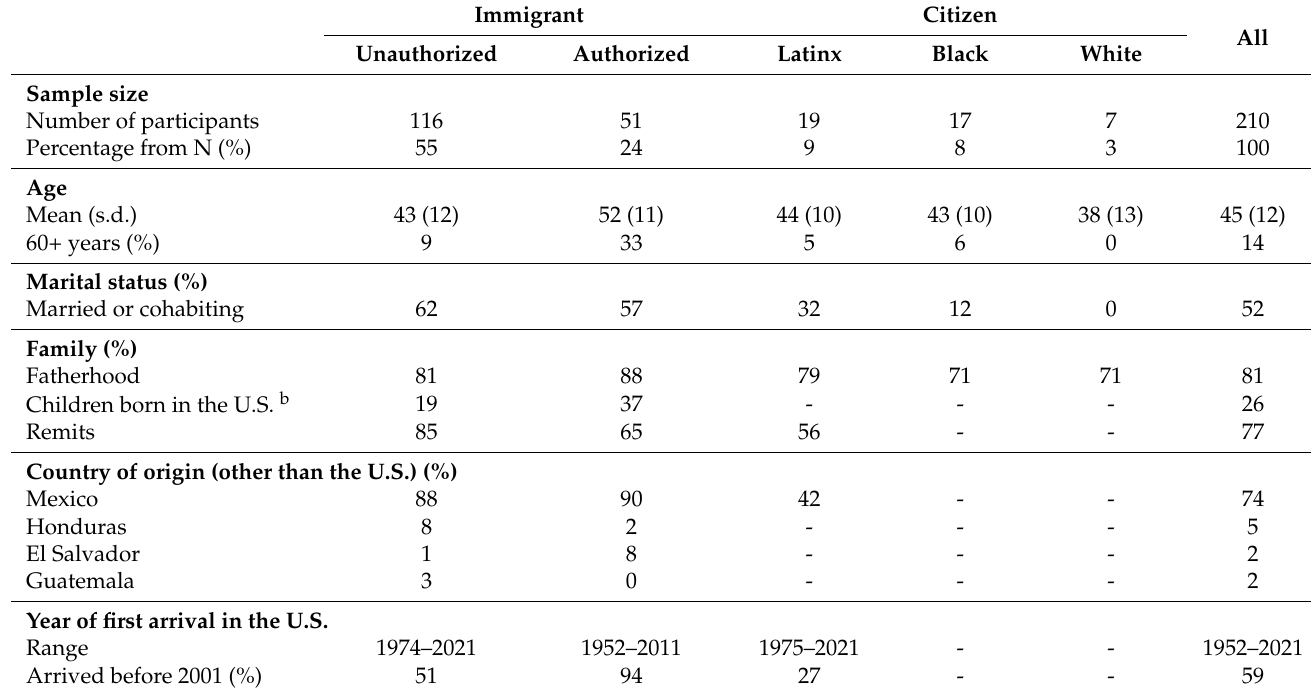
Table 1. Demographic characteristics by immigration status and citizens’ racial categories a